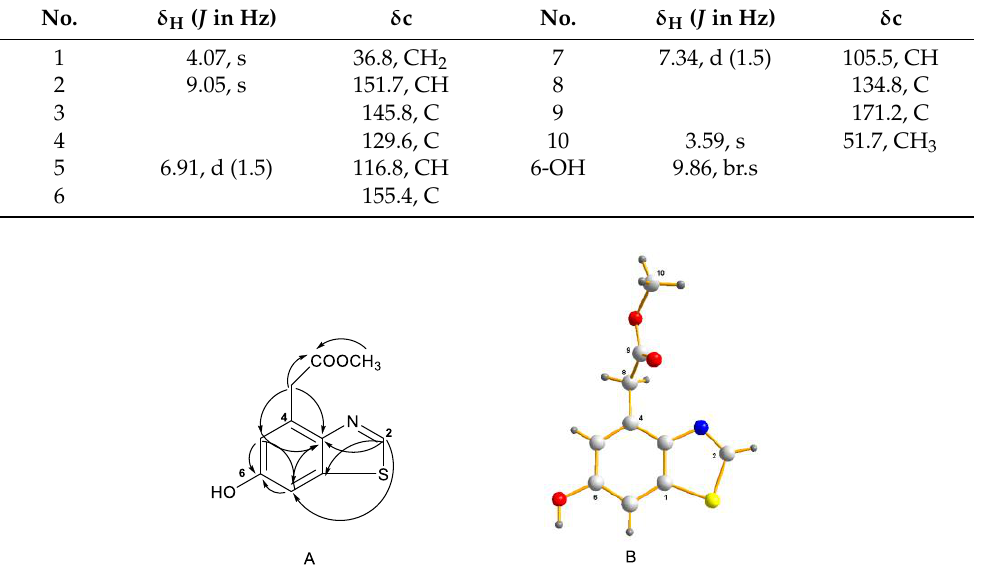
Figure 3. ( A ) Key HMBC correlations of compound 3 ; ( B ) ORTEP diagram of compound 3 . Table 2. 1 H and 13 C NMR data for 3 (500/125 MHz, in DMSO- d 6 , δ ppm, J in Hz).